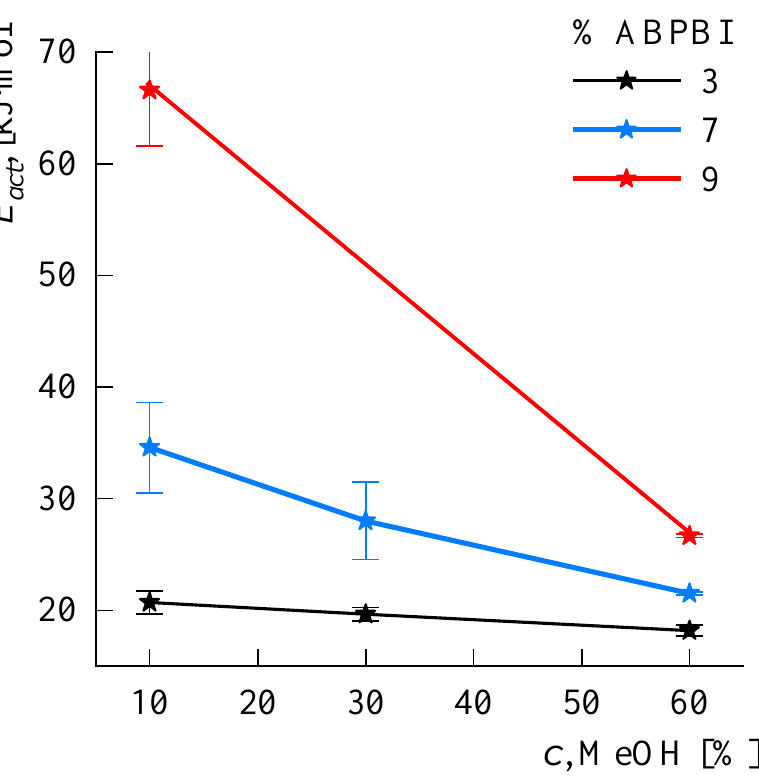
Figure 11. Dependences of the flow activation energy on the content of methanol in the solvent for solutions of different concentration.